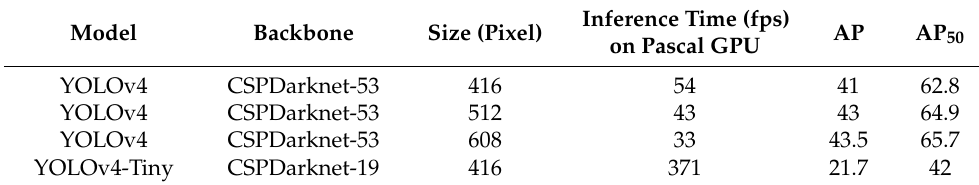
Table 1. YOLOv4 performance